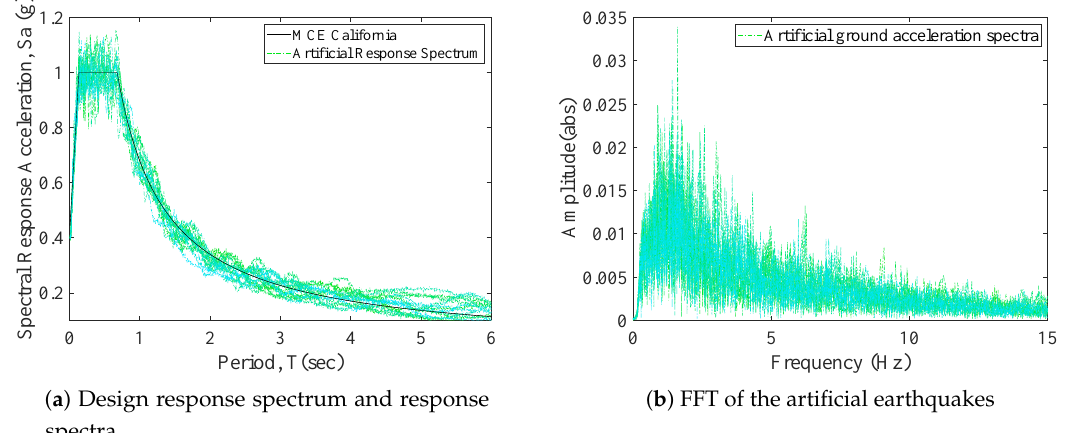
Figure 7. Design response spectrum and Fast Fourier Transforms (FFT) of the input ground acceleration.